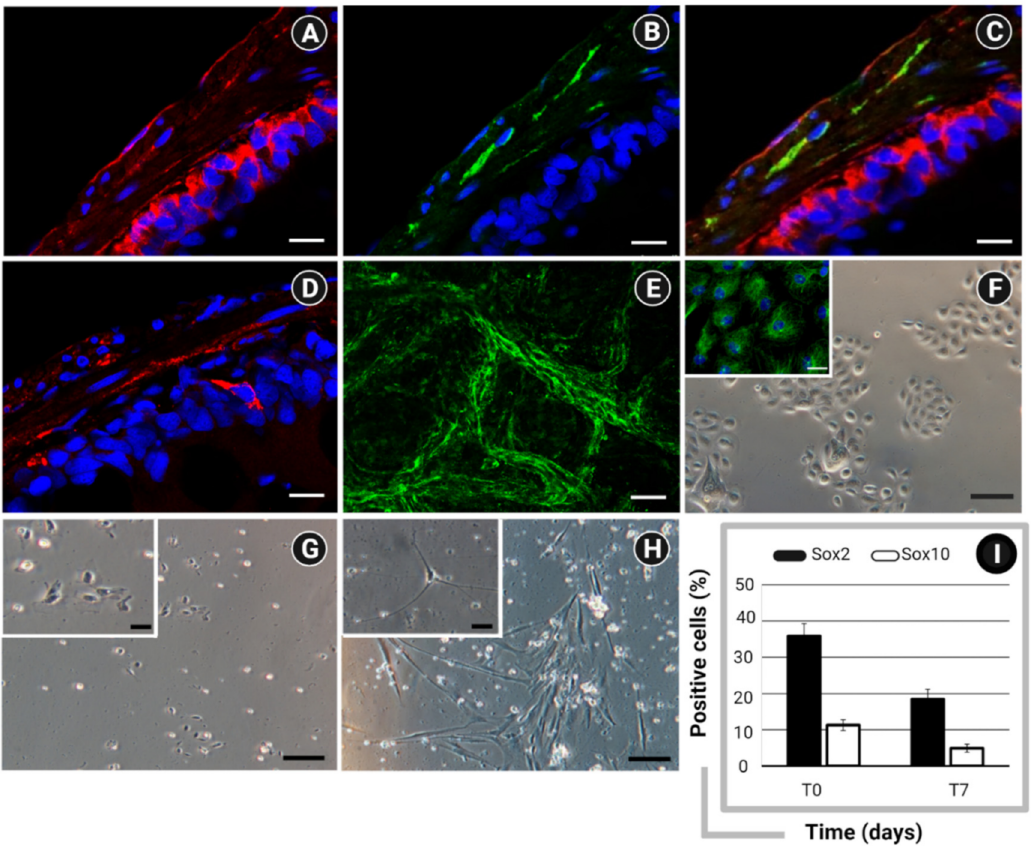
Figure 2. Immunofluorescent staining showing the expression of ( A ) Frizzled 9 (red) within the epithelial and neuromuscular compartments; ( B ) PAN neuronal marker (green) within the neuromuscular layer; and ( C ) both markers (Frizzled 9 and PAN neuronal marker) in colocalization (yellow); and ( D ) Wnt3a within the epithelium and neuromuscular layer. Nuclear counterstaining was performed using DAPI (blue). ( E ) Whole-mount immunofluorescent staining of zebrafish ENS network by detection of PAN neuronal marker (green) Bar: 50 µ m. Optical microscopy of ( F ) primary intestinal epithelial cells, characterized by the expression of Pan-cytokeratin (left corner, green); ENS cultures at ( G ) 24 h and ( H ) 7 days from isolation. Bar: 100 µ m (200 µ m in left corner). ( I ) Flow cytometry analysis of Sox2 and Sox10 in ENS cells at the time of isolation (T0) and after culturing for 7 days (T7). Data are expressed as percentage (%) of positive cells ± standard deviation (SD). Created with BioRender.com, accessed on 31 October